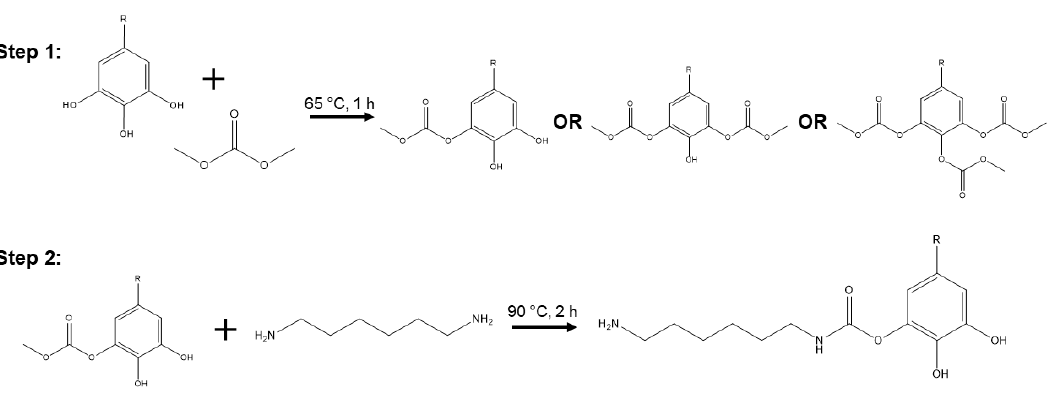
Figure 1. Two-step NIPU synthesis: ( Step 1 ) the carbonation of tannic acid with dimethyl carbonate, resulting in mono-, di-, or tri-substitution and ( Step 2 ) the formation of a single urethane, shown here with monosubstitution.